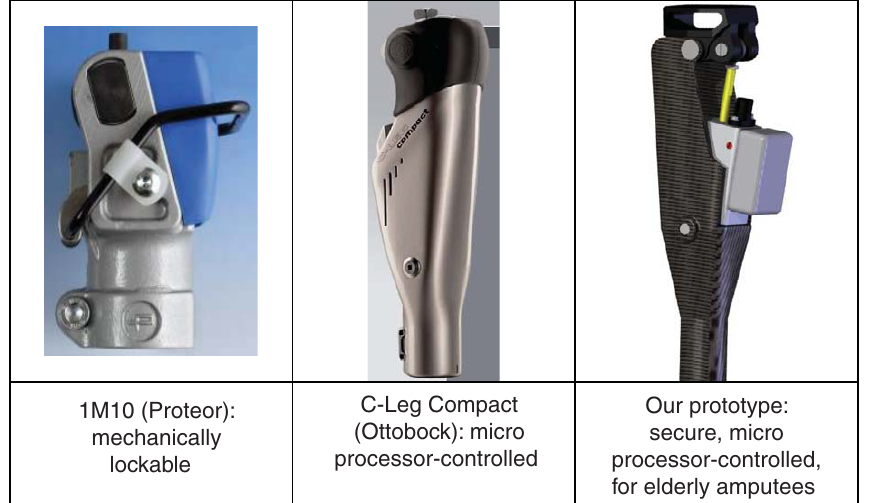
Fig. 1. Examples of prosthetic